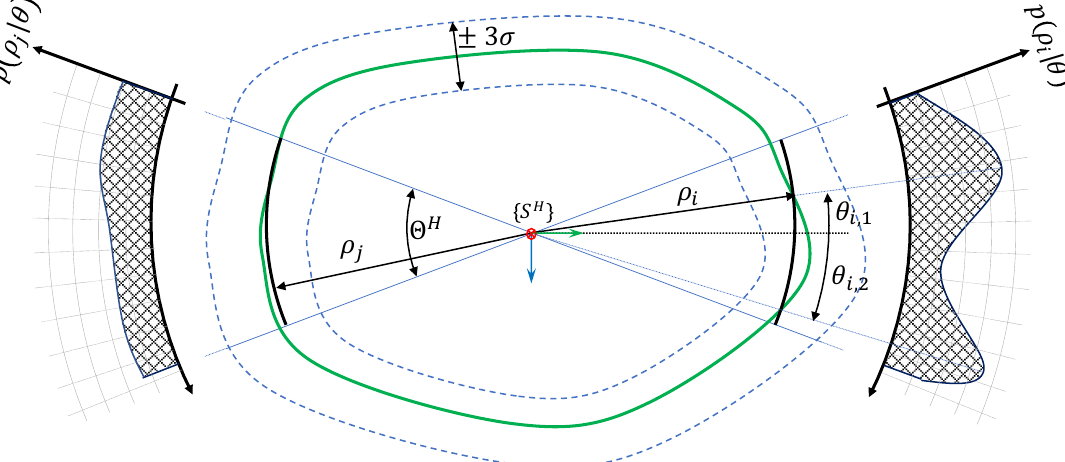
Figure 6. Illustration of elevation angle maximum likelihood estimation on a vertical slice. The green curve is the mean surface (cofounded here with the true surface for visibility) and blue curves are the confidence interval at 3 σ . Note that in this particular configuration ρ = ρ h = ˆ ρ v . ±